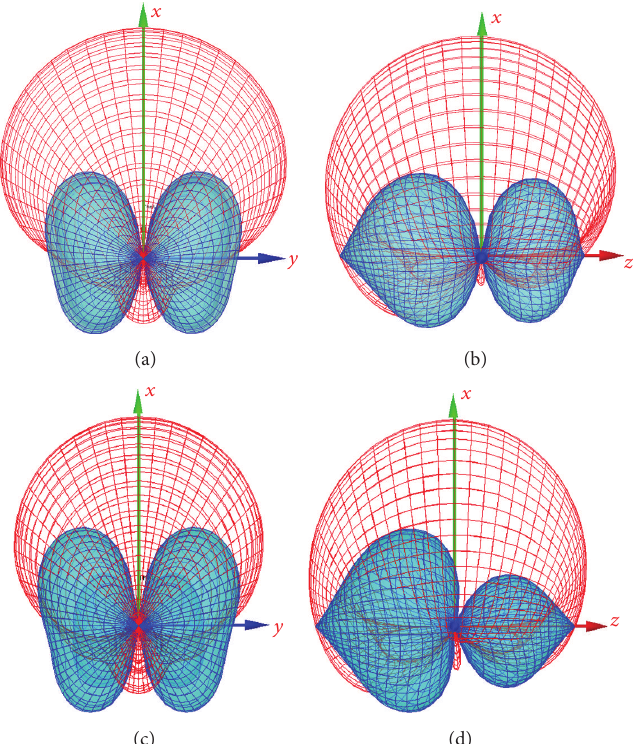
Figure 9: 3D radiation patterns. (a, b) CBHM antenna. (c, d) Conventional probe-fed rectangular-patch microstrip antenna ( 𝜀 𝑟 = 4.2, 𝛿 = 0.02, h = 6.6 mm, a = 26.2 mm, b = 35 mm, 𝑦 𝑝 = b /2, and 𝑧 𝑝 = 5mm). Co-pol: red pattern; cross-pol: blue